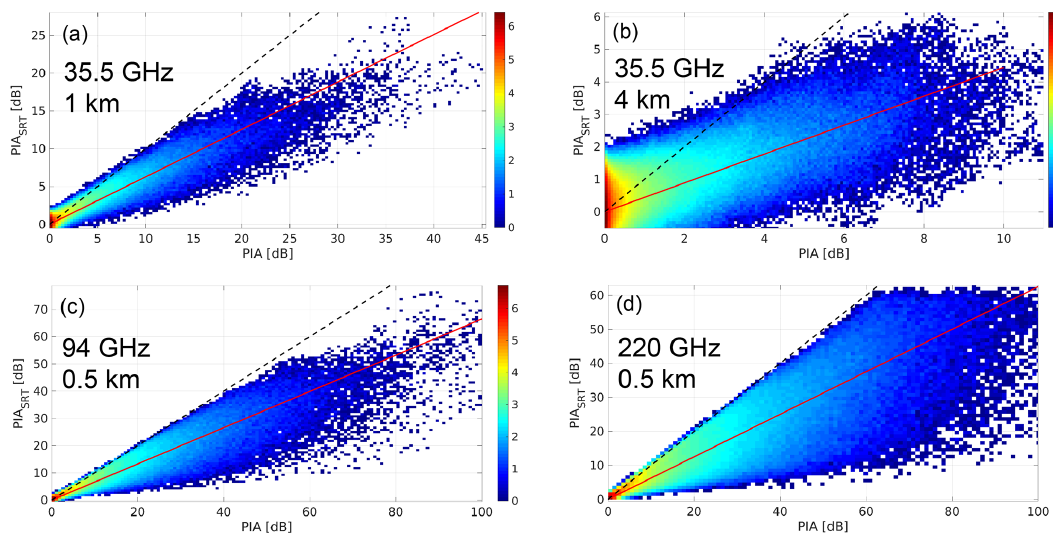
Figure 9. Illustrating the impact of NUBF on estimate of the hydrometeor PIA via the surface reference technique: density scatterplot of hydrometeor PIA vs. PIA SRT for the whole dataset of RICO simulations for Ka-band radars with footprint of 1km (a) and 4km (b) and for footprints of 0.5km at 94GHz (c) and 220GHz (d) .